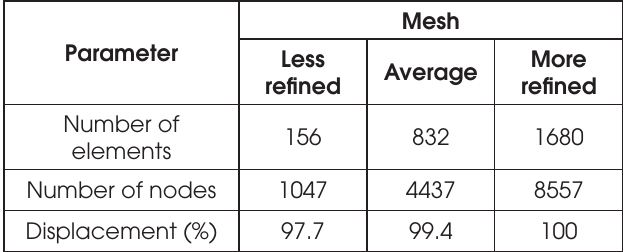
Parameter of meshes adopted for convergence